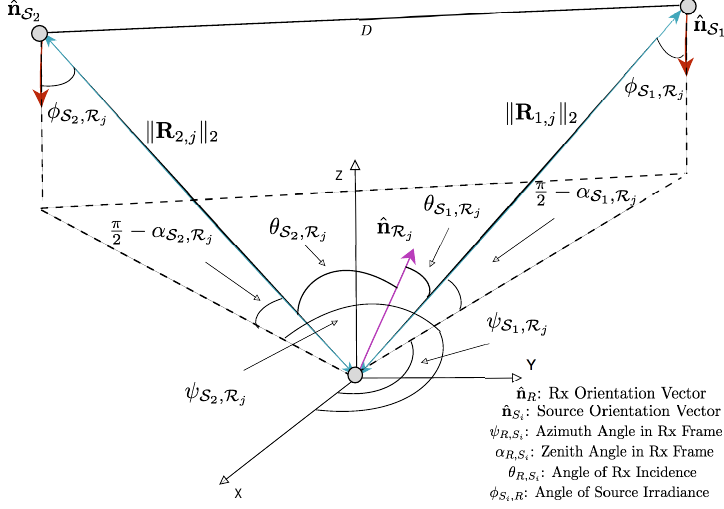
Figure 6. Two Source-Single Receiver Geometry Illustration for Azimuth and Elevation Angle of Arrival Measurement with Local Coordinate